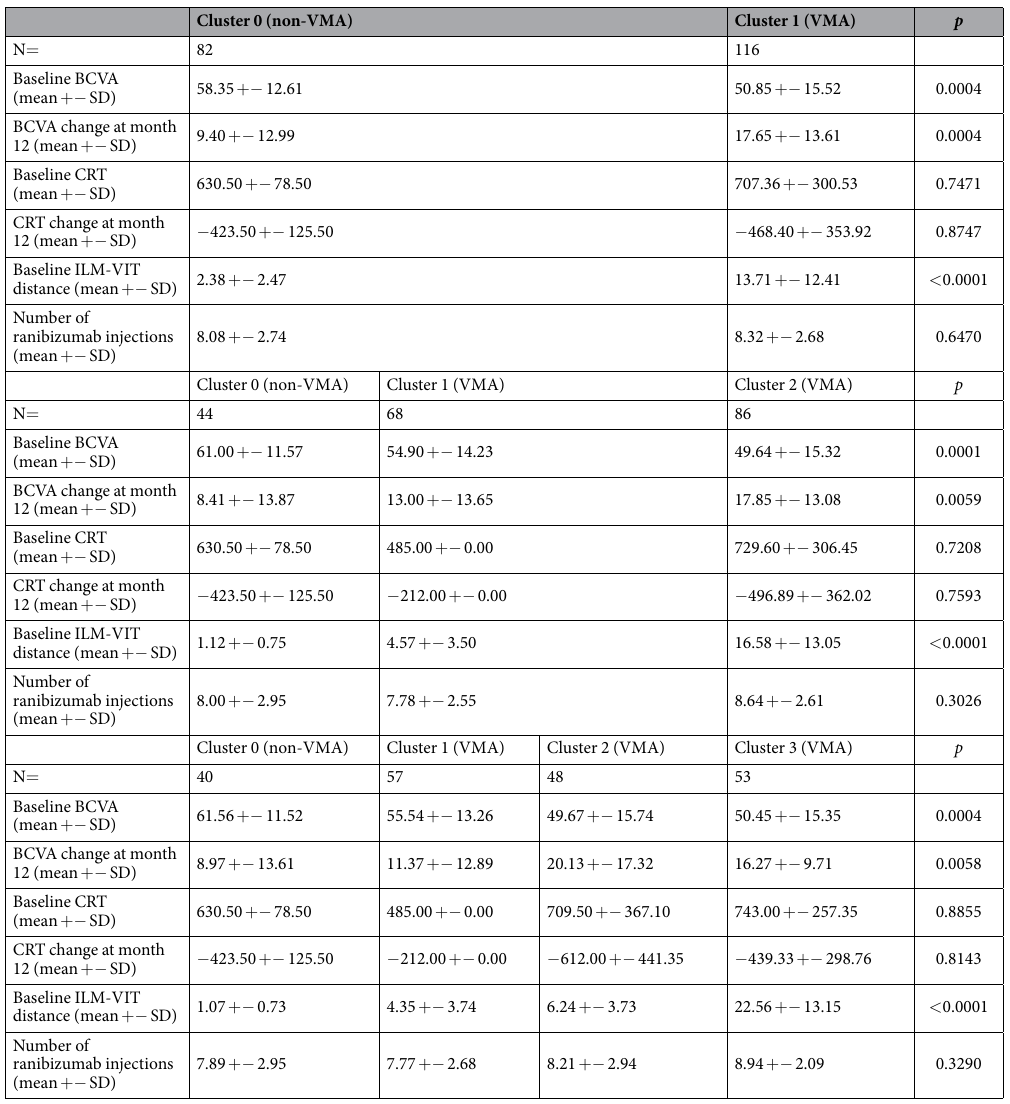
Table 2. Characteristics of vitreomacular interface clusters in central retinal vein occlusion (CRVO). BCVA = best-corrected visual acuity; SD = standard deviation; CRT = central retinal thickness; ILM = internal limiting membrane; VIT = posterior vitreous